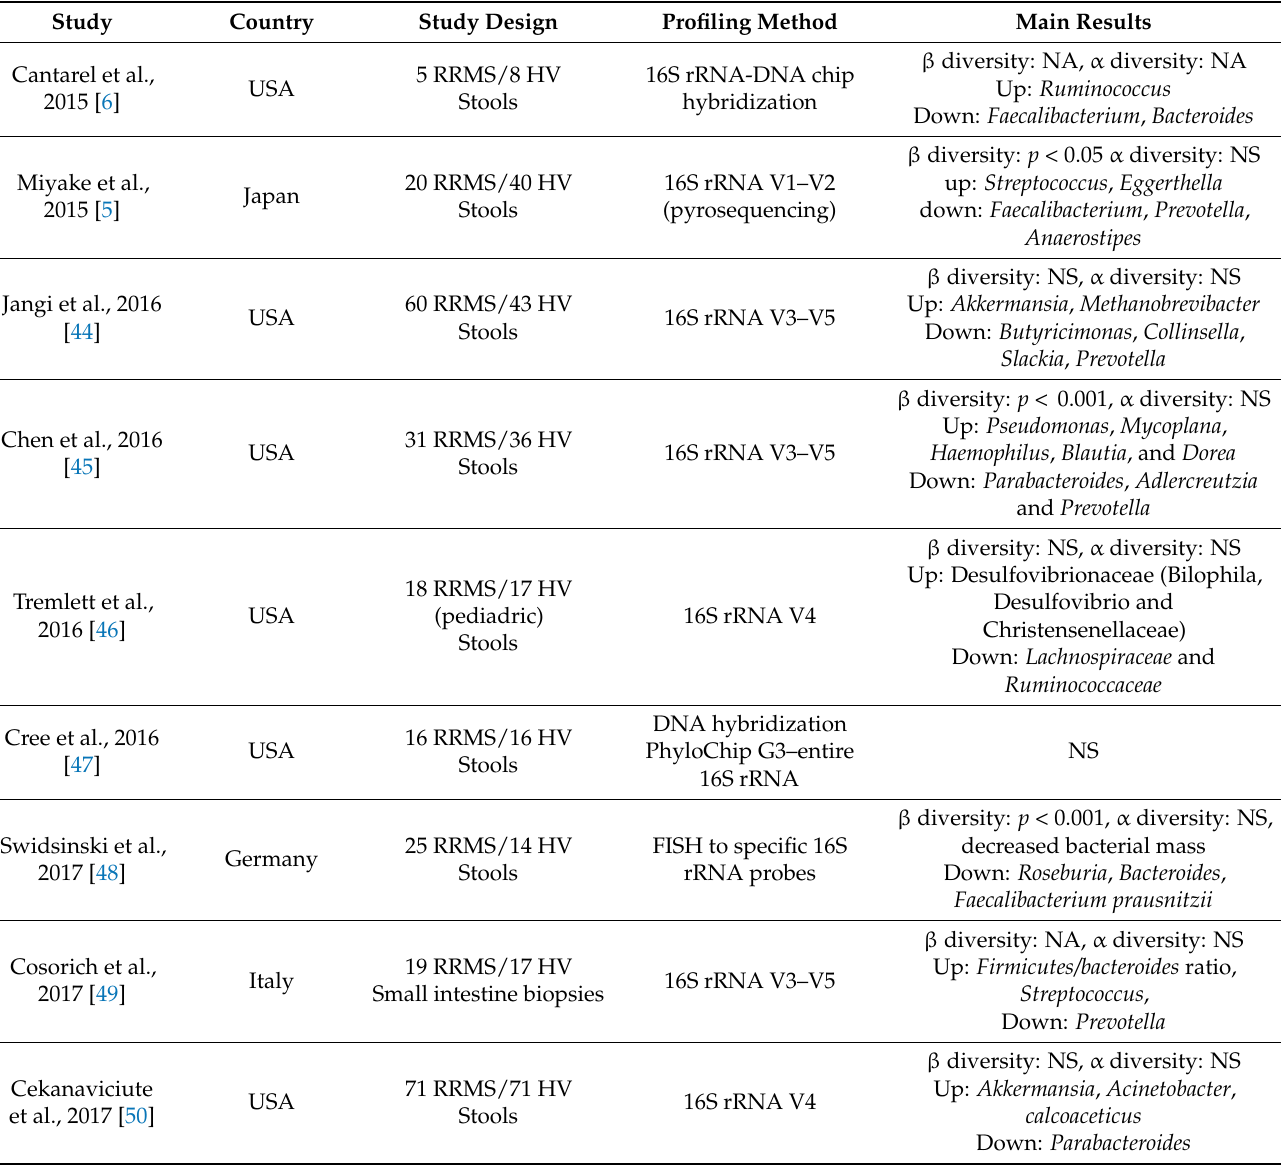
Table 1. Studies investigating the gut microbiome alterations in multiple sclerosis